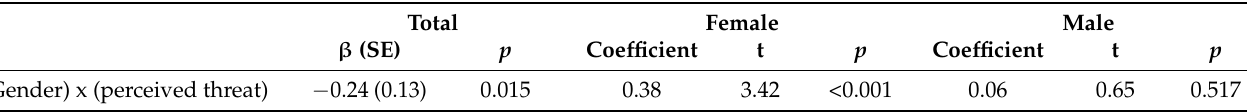
Table A4. Multiple hierarchical regression for preventive behavior, with the interaction of gender and perceived threat ( N =